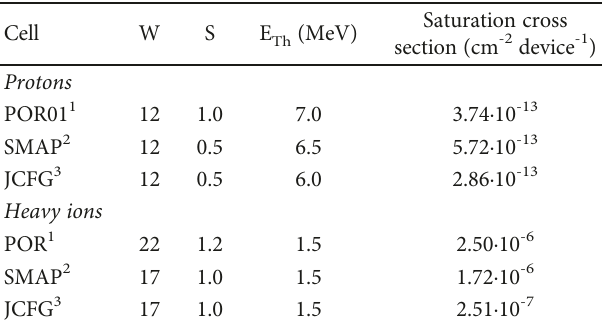
Table 3: Virtex-II irradiation SEFI results. Weibull fi tting parameters.